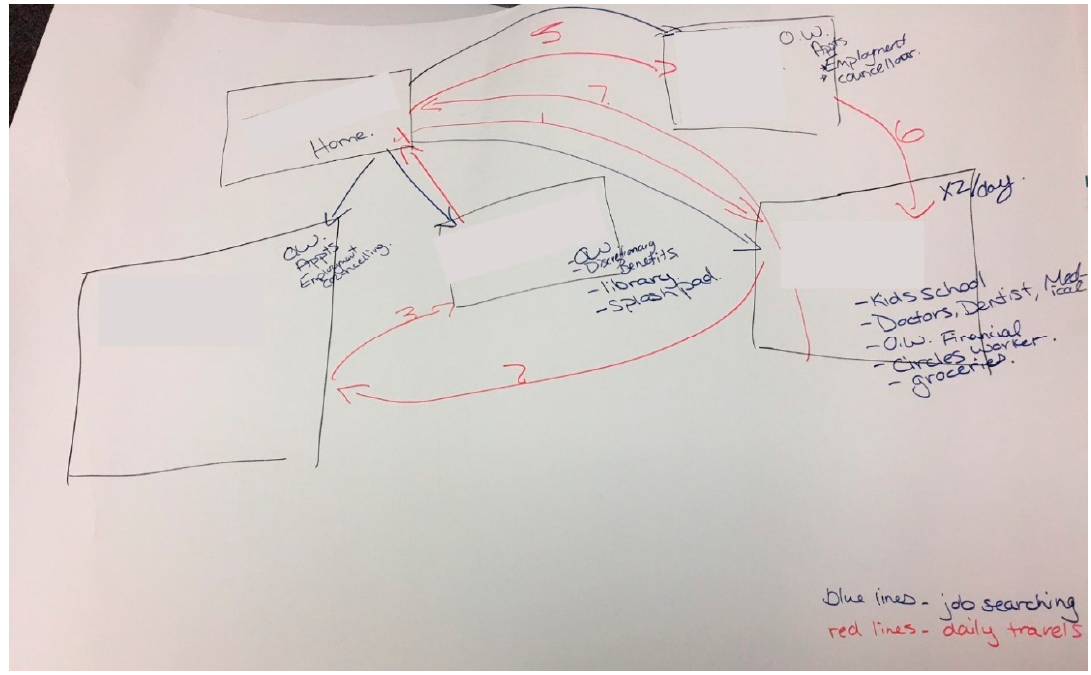
Figure 2. Audrey’s map.